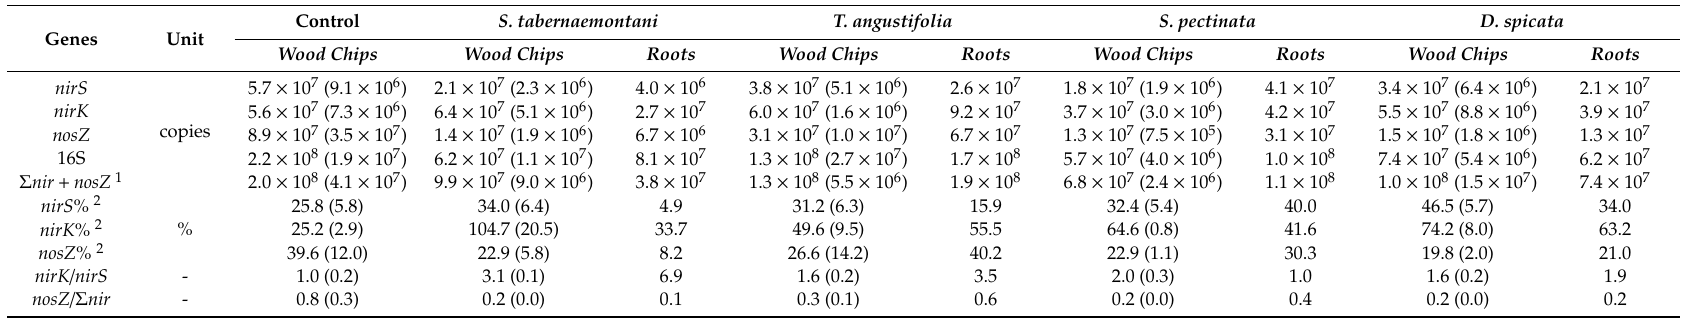
Table 2. Functional denitrifying gene parameters ± (SD) in the biofilm from the wood-chip samples (average of 3 depths), as well as the root samples. Genes Unit